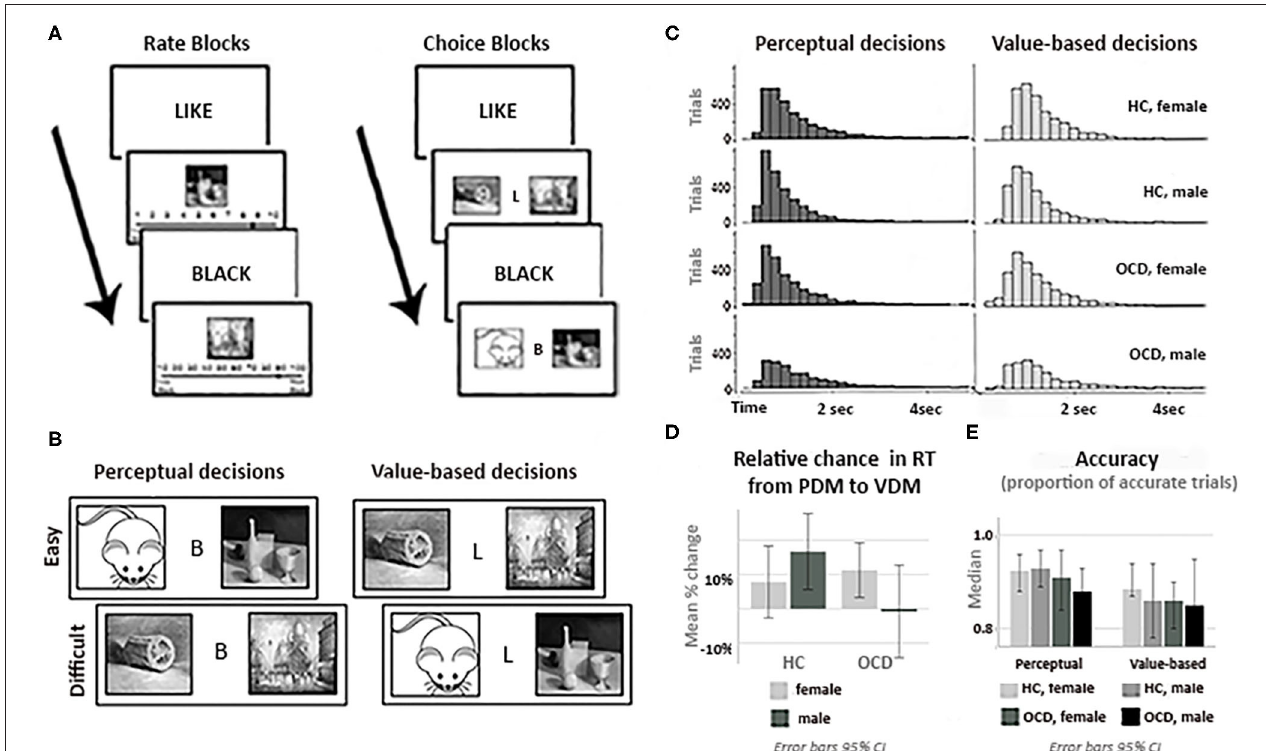
FIGURE 2 | Experimental tasks and behavioral analyses. (A) Trial structure: rate (Phase I) and choice (Phase II) phases. (B) Task stimuli: the same neutral images were used for perceptual (PDM) and value-based (VDM) trials. (C) RT histograms for PDM and VDM trials for all participants groups. (D) Relative change in the mean reaction time (RT) from PDM to VDM choices by diagnostic group and gender. (E) The median accuracy (proportion of trials with accurate responses, based on rate II) for all participants groups during PDM and VDM trials. Accuracy of choices during PDM or during VDM trials, as well as the percentage change in accuracy from PDM to VDM trials, did not differ significantly across the diagnostic or gender groups. Error bars in (D,E) . are 95% CI.